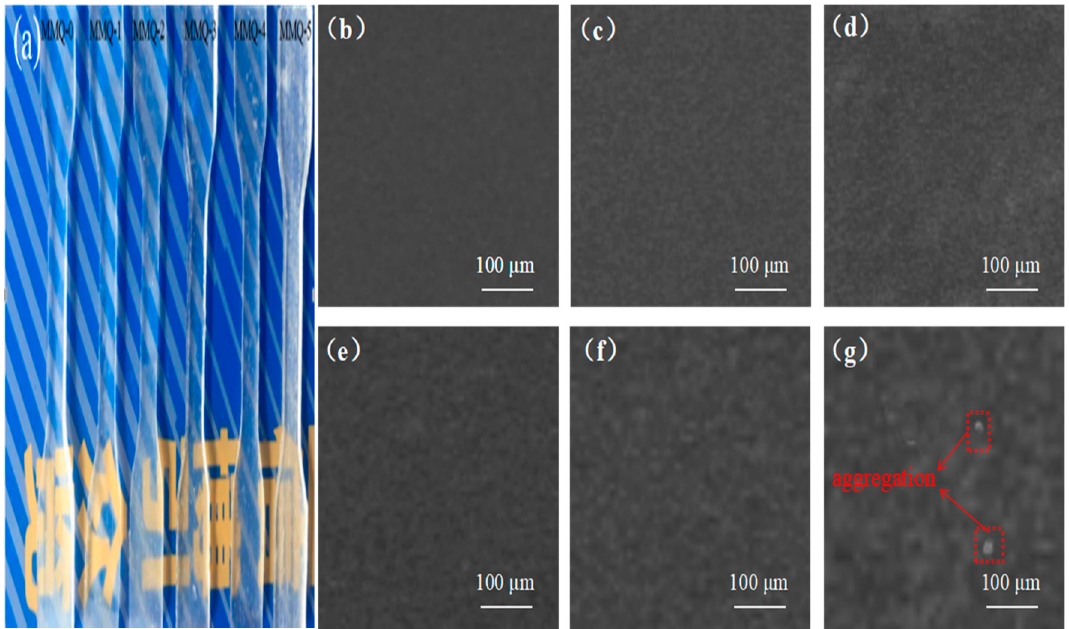
Figure 4. Morphology of the RTV silicone rubbers. ( a ) Photographs of samples from MMQ-0 to MMQ-5. SEM micrographs of RTV silicone rubbers. ( b ) MMQ-0, ( c ) MMQ-1, ( d ) MMQ-2, ( e ) MMQ-3, ( f ) MMQ-4 and ( g ) MMQ-5.